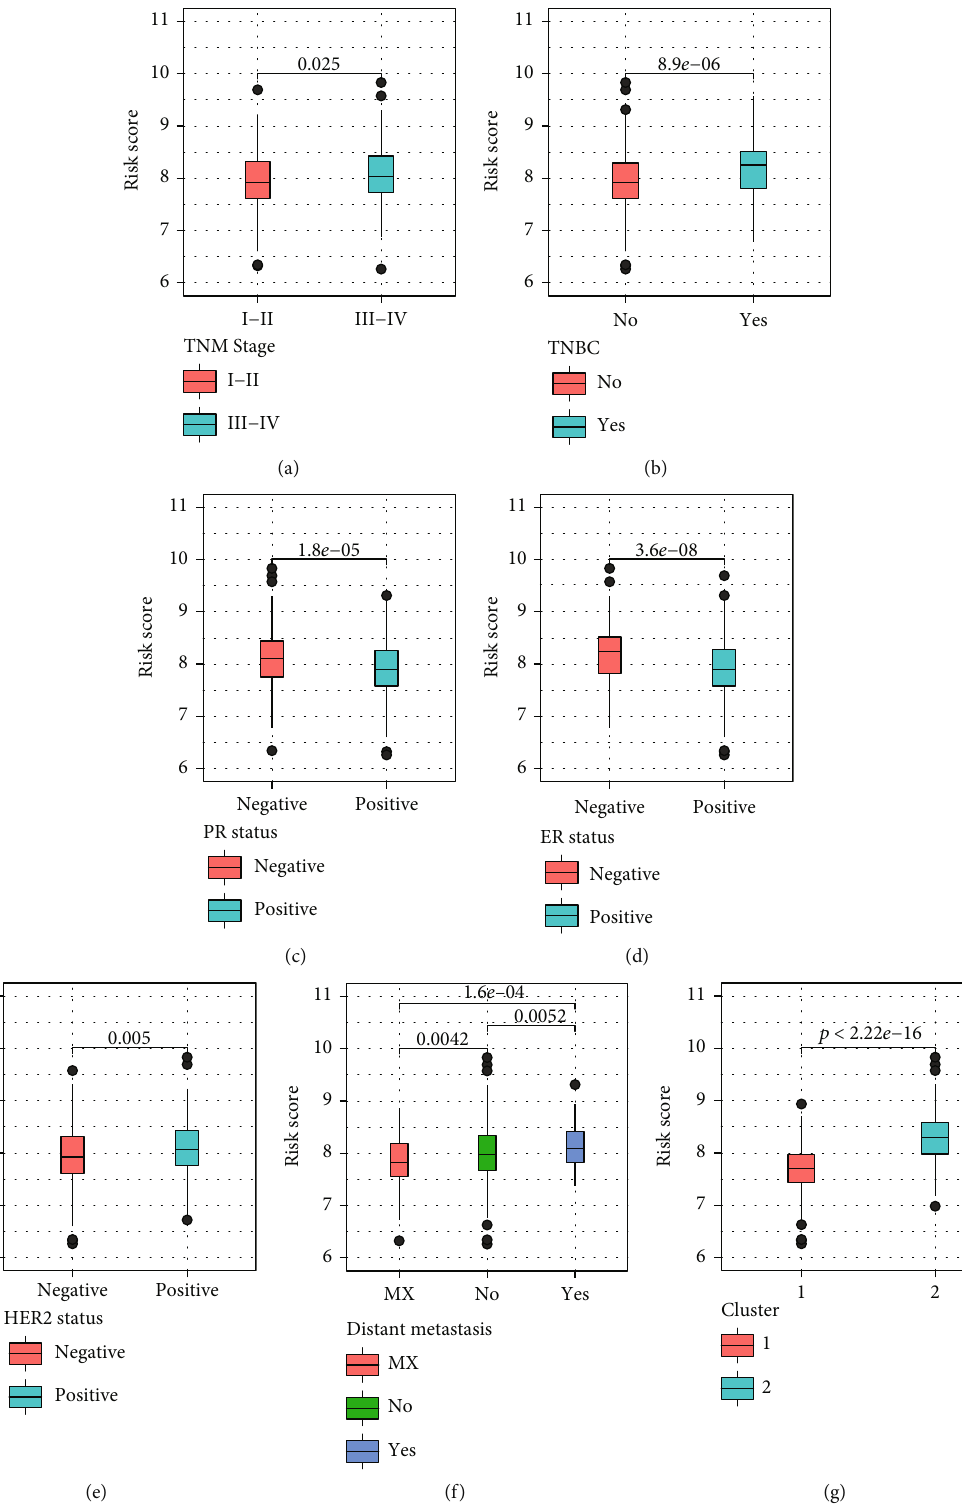
Figure 5: Relationships between the risk score model and important clinical characteristics. (a) TNM stage, (b) triple-negative status, (c) estrogen receptor (ER) status, (d) progesterone receptor (PR) status, (e) Her-2 status, (f) metastasis status at diagnosis, and (g) cluster group. The di ff erences were compared using the Wilcoxon